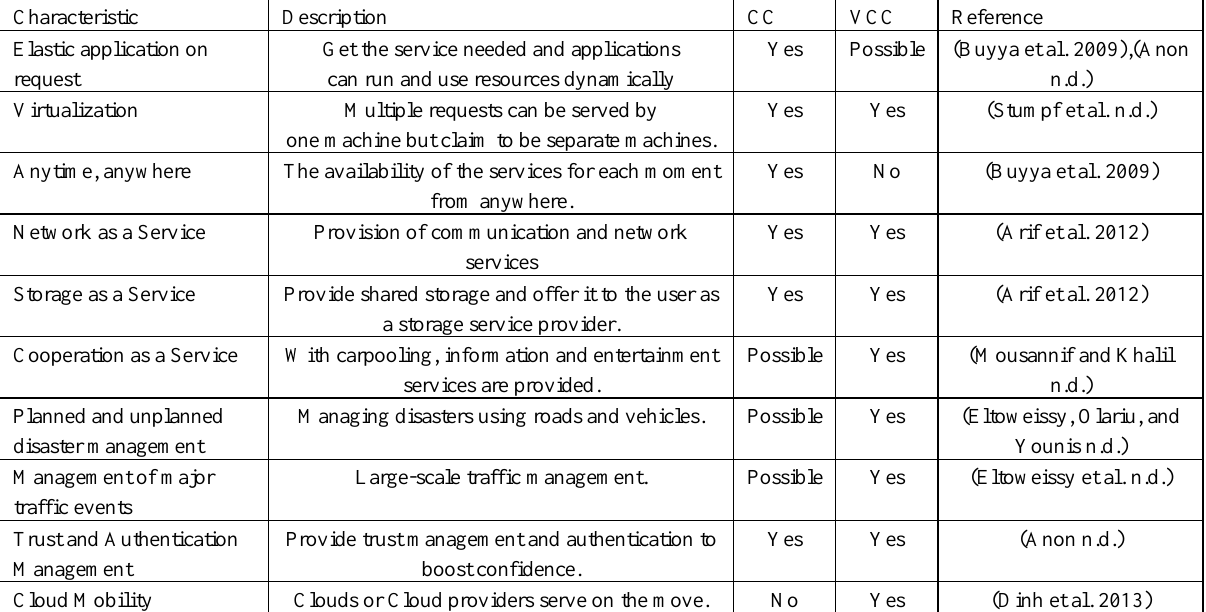
TABLE I.I: comparison between CC and VCC